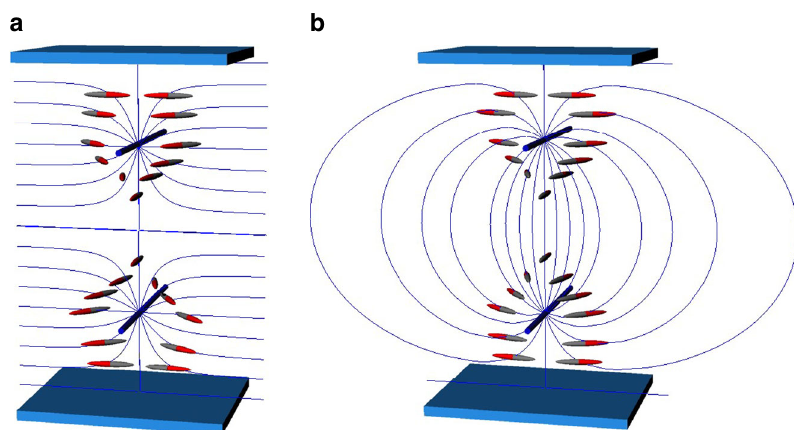
Fig. 2 Director con fi gurations around two parallel twist disclination lines con fi ned in a planar cell. a Con fi guration depicted according to Eq. (1) for the same handedness case. b Con fi guration of the opposite handedness case. Although the director of a nematic LC does not have a head – tail asymmetry, different colors are applied to highlight the differences in the topology of twist states. In a , the pair of the disclination lines separate the regions of ± π twisted states; in b , both sides of the disclination pair are untwisted, and the deformation is con fi ned in the vicinity of the disclinations, which creates the attractive force between the disclination lines. The con fi guration in b is not in mechanical equilibrium without the aid of external